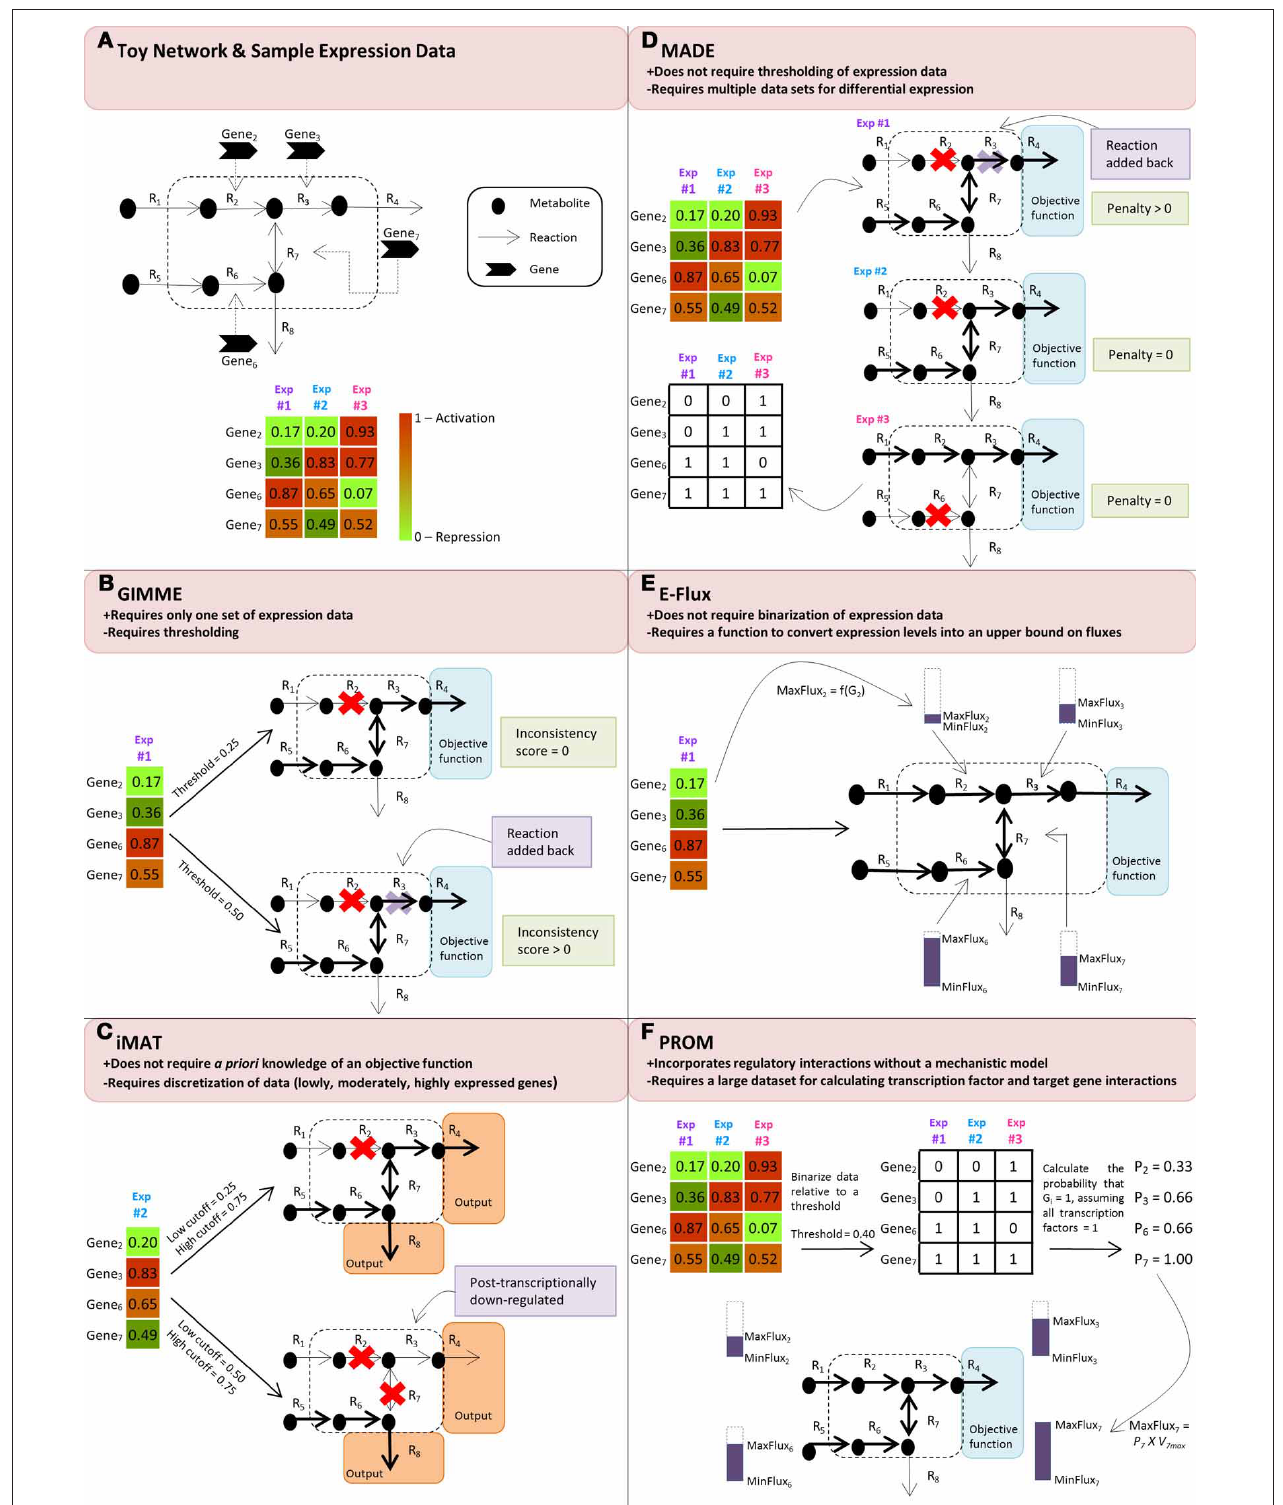
FIGURE 1 | (A) Toy network and sample expression data for three different experimental conditions. Panels (B) , (C) , (D) , (E) and (F) demonstrate how the discussed algorithms use the sample expression data to modify